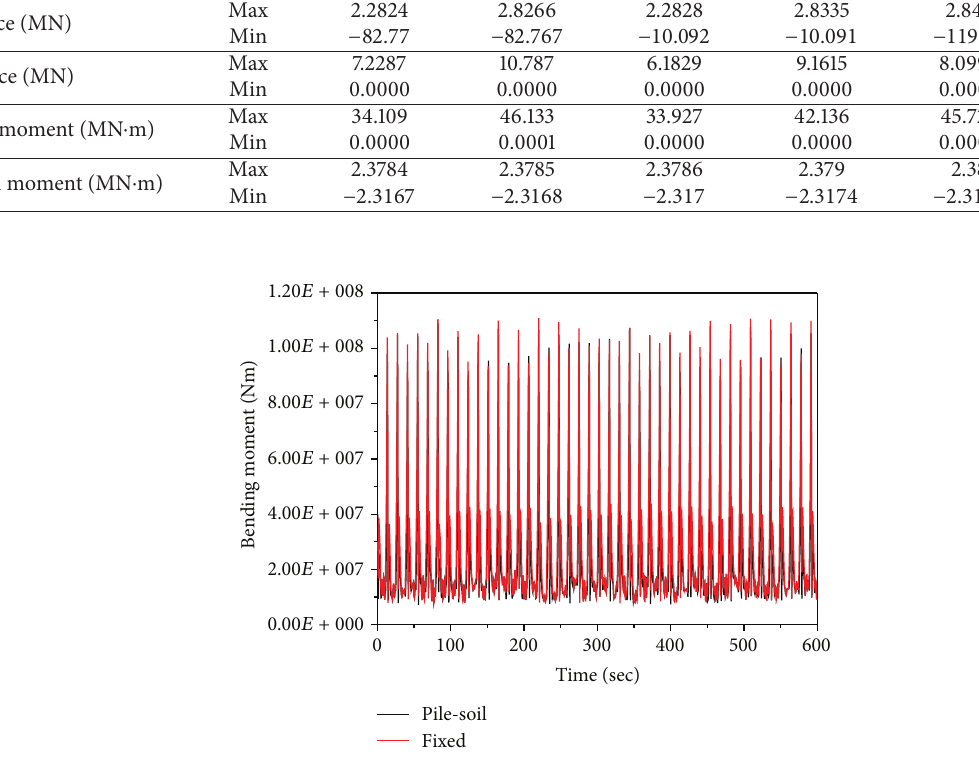
Figure 11: Maximum bending moments with regular wave at MSL.